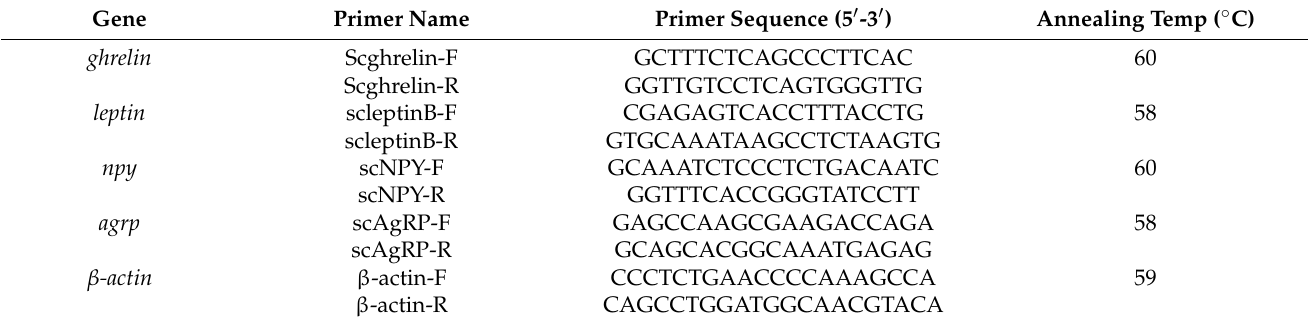
Table 1. Sequences of primer pairs used for real-time quantitative PCR in this